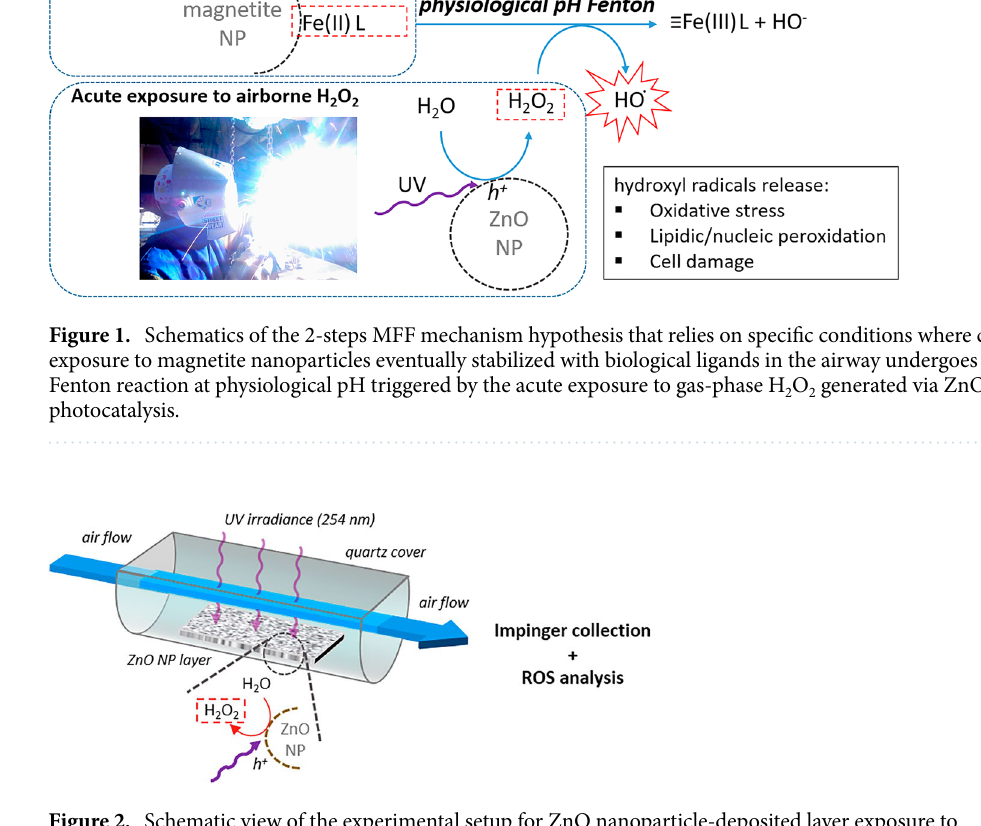
Figure 2. Schematic view of the experimental setup for ZnO nanoparticle-deposited layer exposure to UV radiation (254 nm) and subsequent quantitative determination of the airborne H 2 O 2 photocatalytically produced.